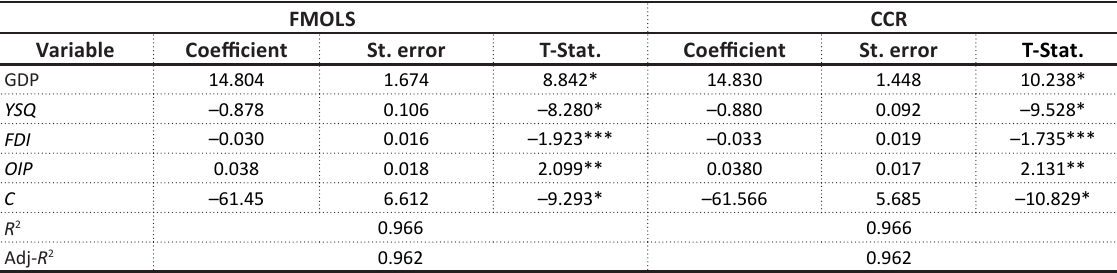
Table 10. FMOLS and CCR